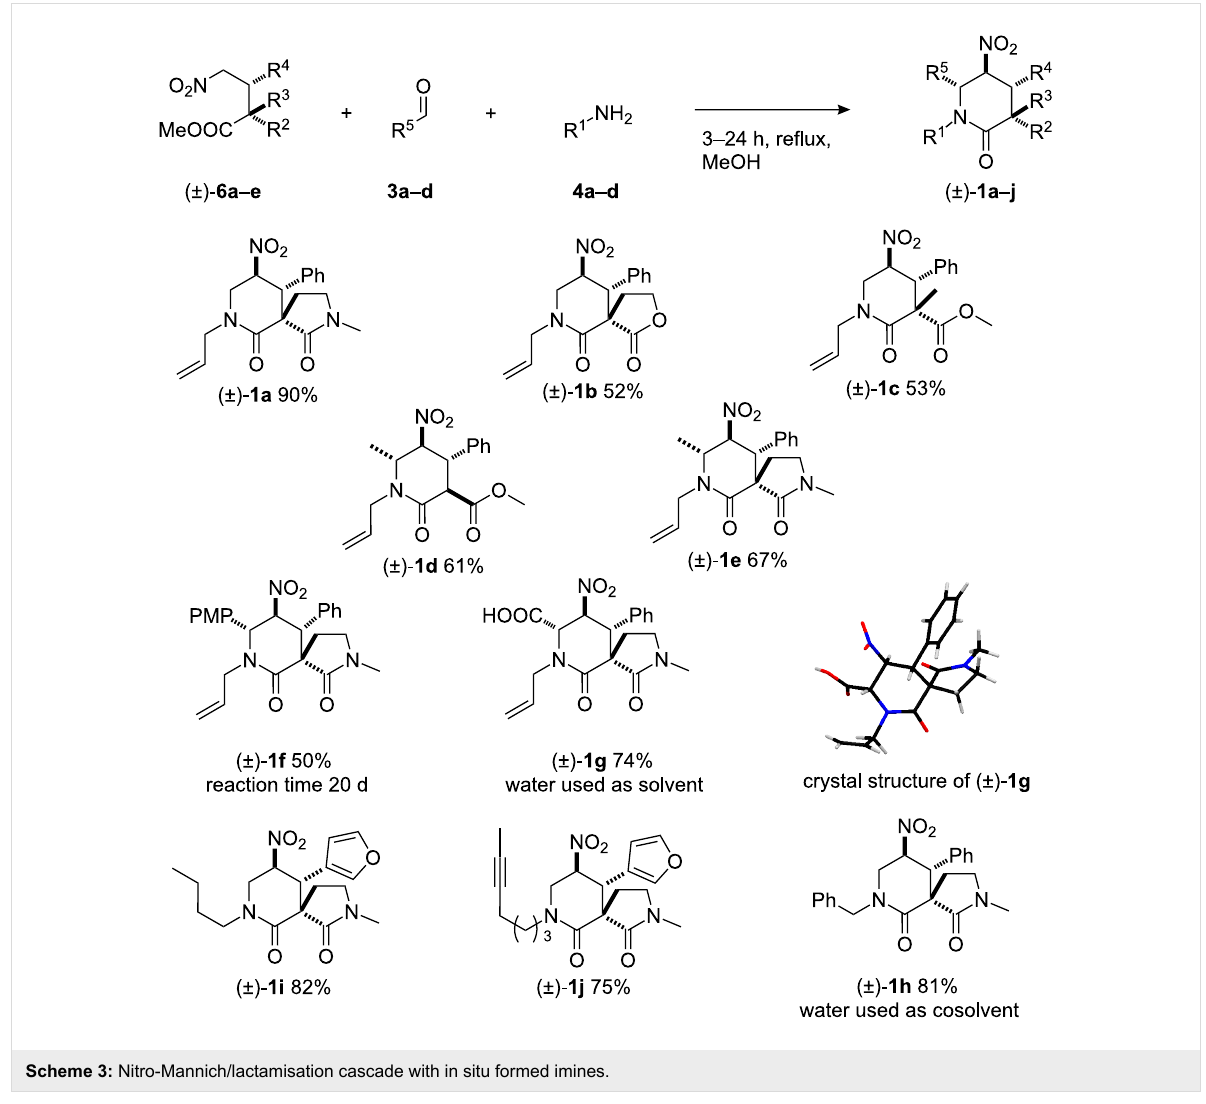
Scheme 3: Nitro-Mannich/lactamisation cascade with in situ formed imines.